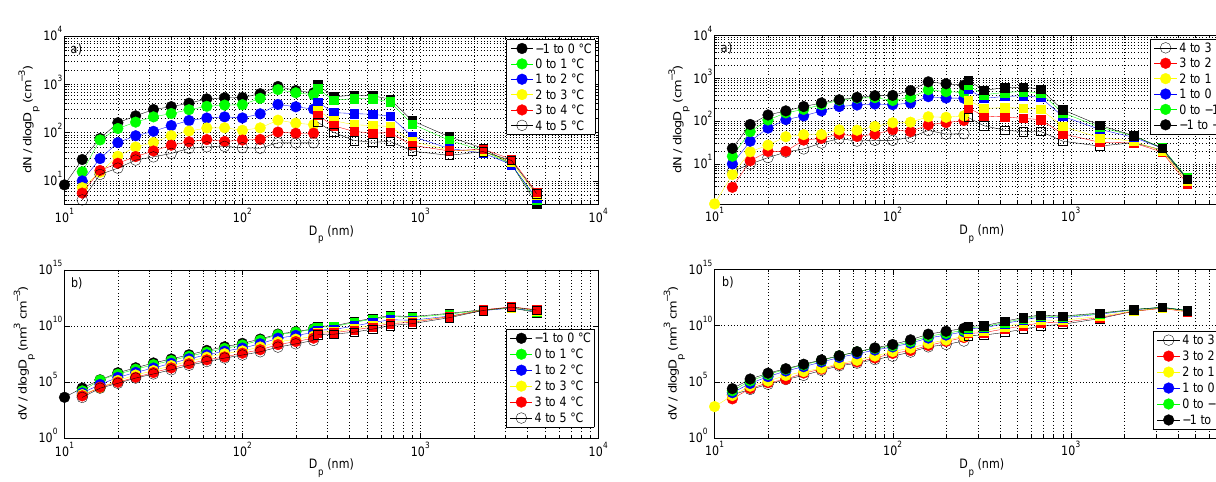
Fig. 10. (a) Median particle number size distributions for different water temperatures. (b) Particle volume size distributions for dif- ferent water temperatures. The warming experiment was conducted with water sampled outside the fjord on 3 March 2010. The part of the size distribution measured by DMPS is marked with circles, whereas the part measured by OPC is marked with squares. Only every second bin data point is shown for clarity.